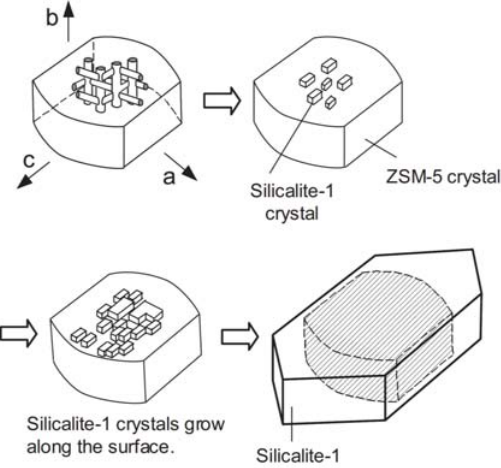
Figure 11. Graphical illustration of the proposed model for the formation of a silicalite-1 layer on a ZSM-5 crystal. Reprinted with permission from [269]. Copyright (2005) John Wiley and